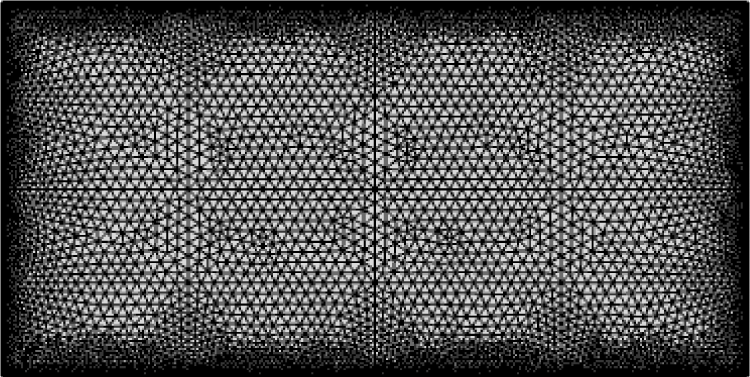
Figure 3. Free triangular node mesh applied to the investigated nanofluid domain.